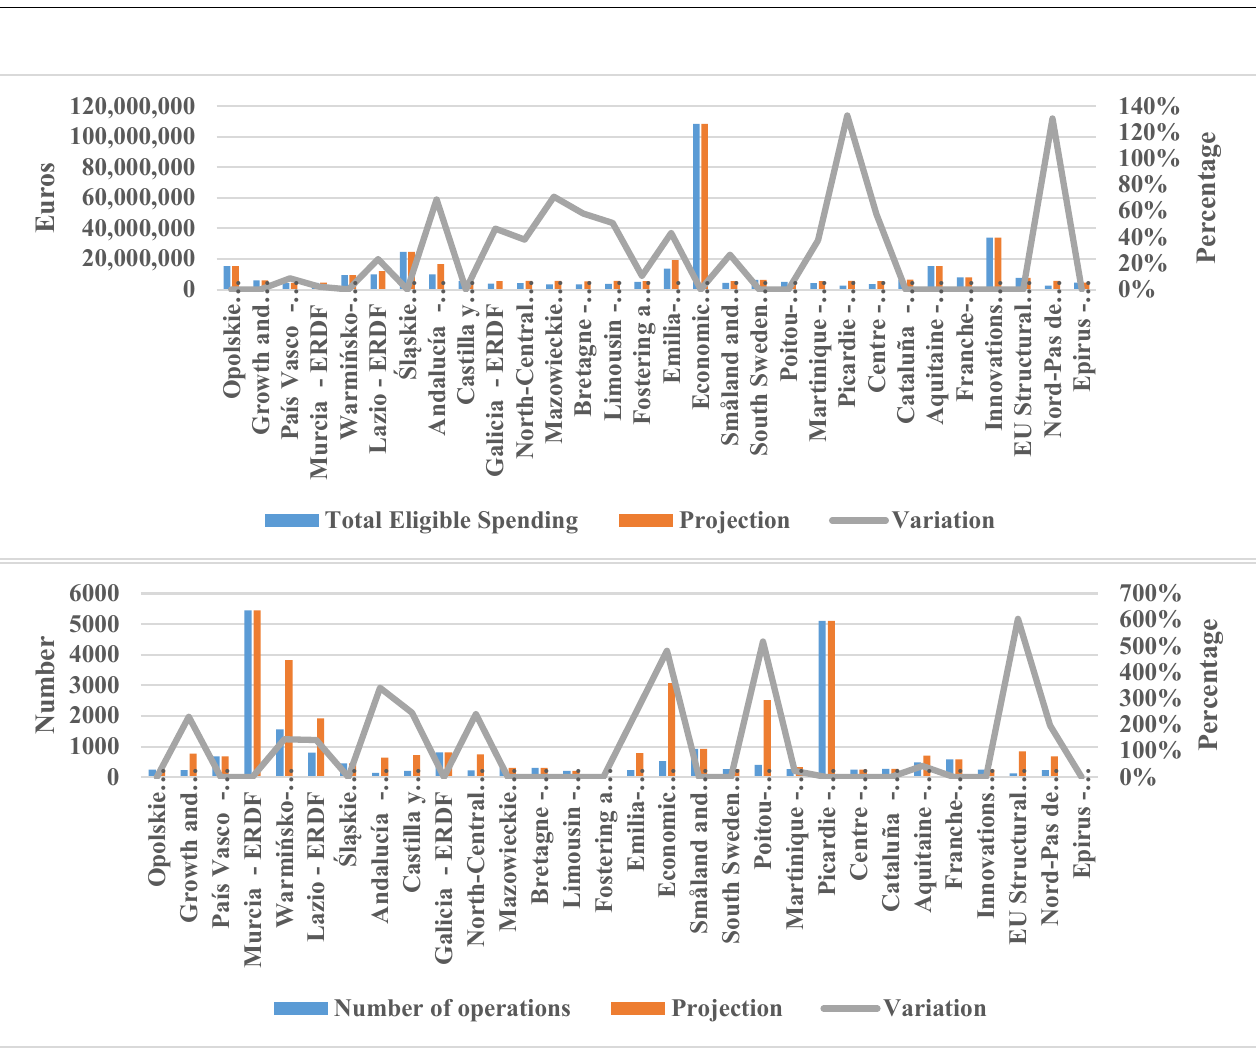
Figure 11. Potential output improvements for every inefficient OP.